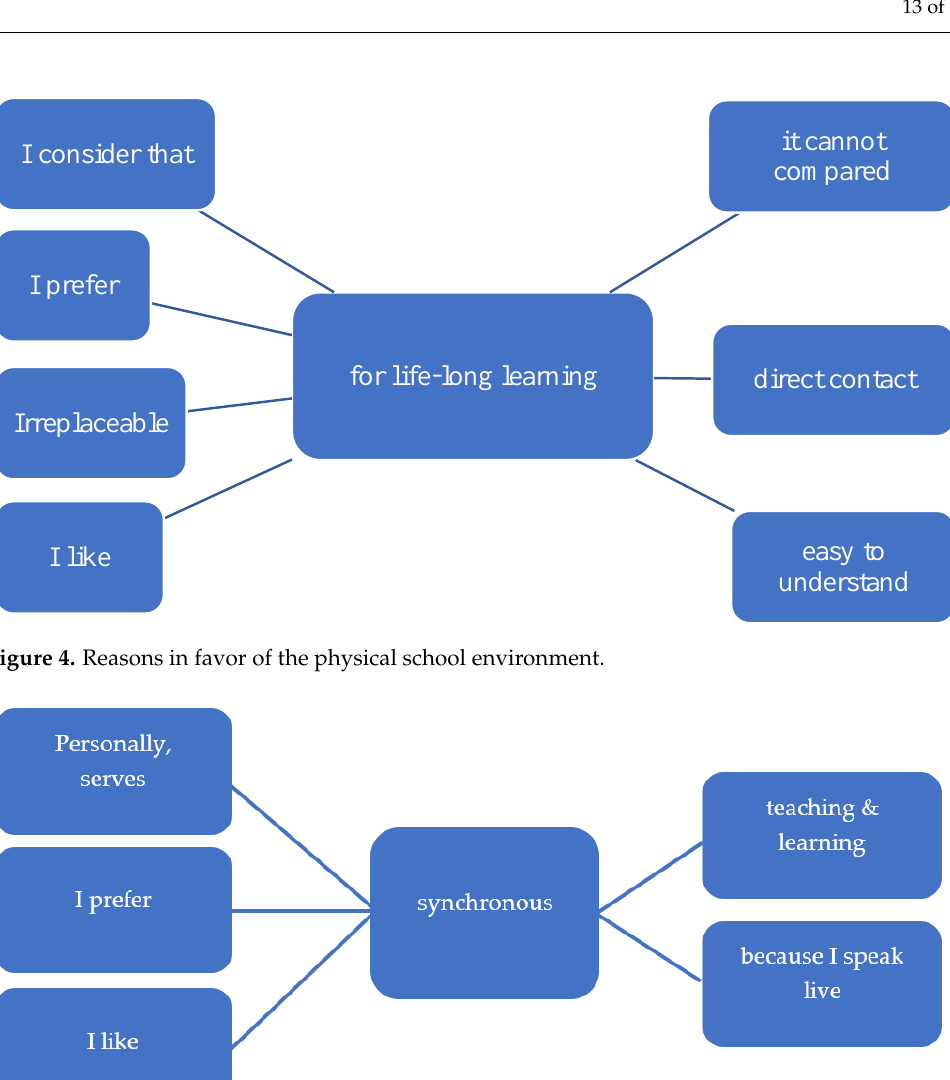
Figure 5. Reasons in favor of the synchronous online education.